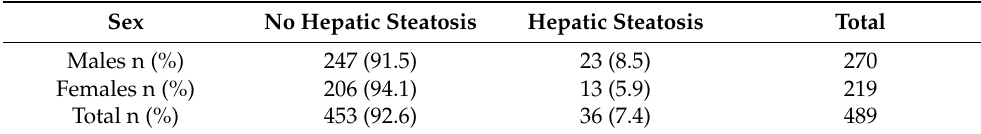
Table 2. Children with ultrasonographic signs of hepatic steatosis according to